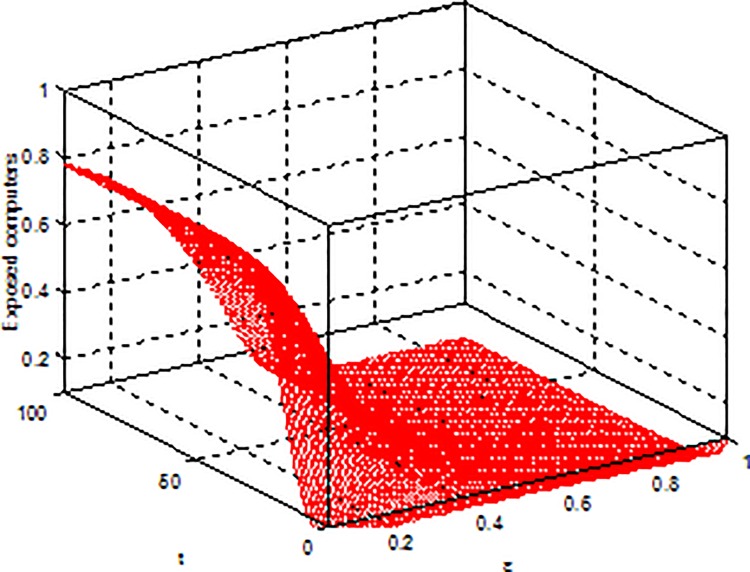
Dynamical behaviors of every system variable with parametersε-E(t).